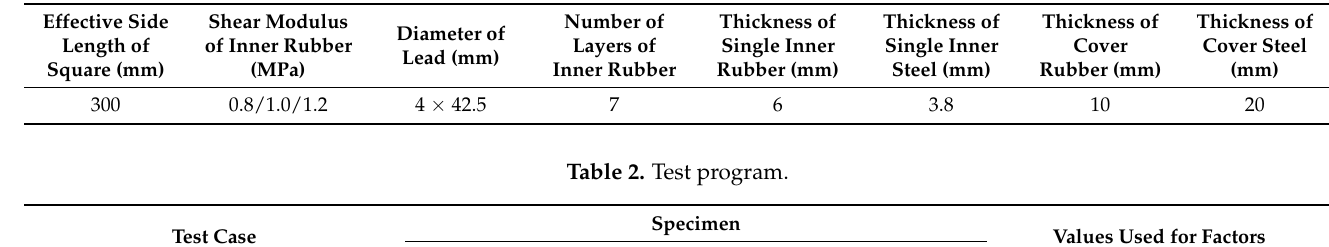
Table 1. Detailed structures of LRB or SHDR.